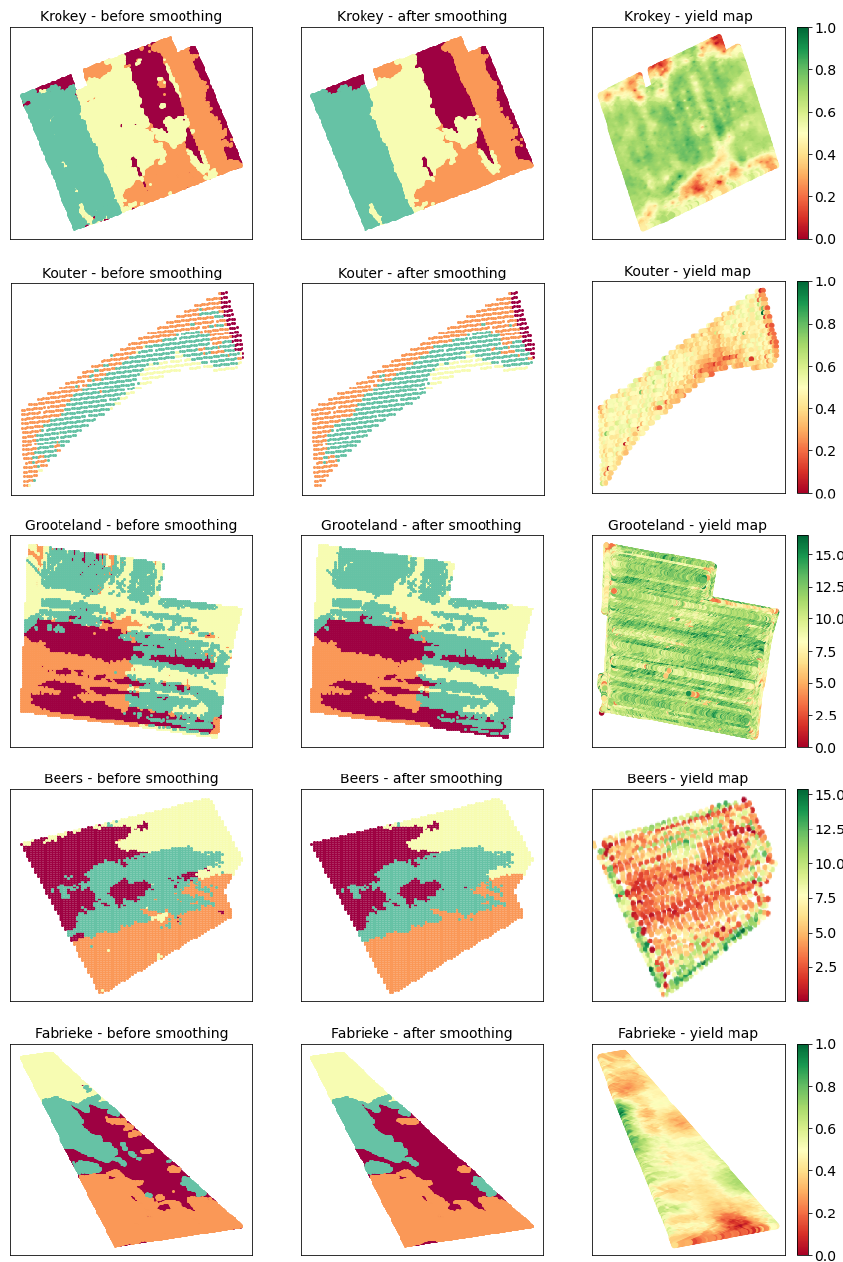
Figure 8. The clustering results before and after smoothing and comparing them with the yield maps in the study fields. The clustering schemes in the middle column are the outcome of management zone delineation by clustering and smoothing pipeline